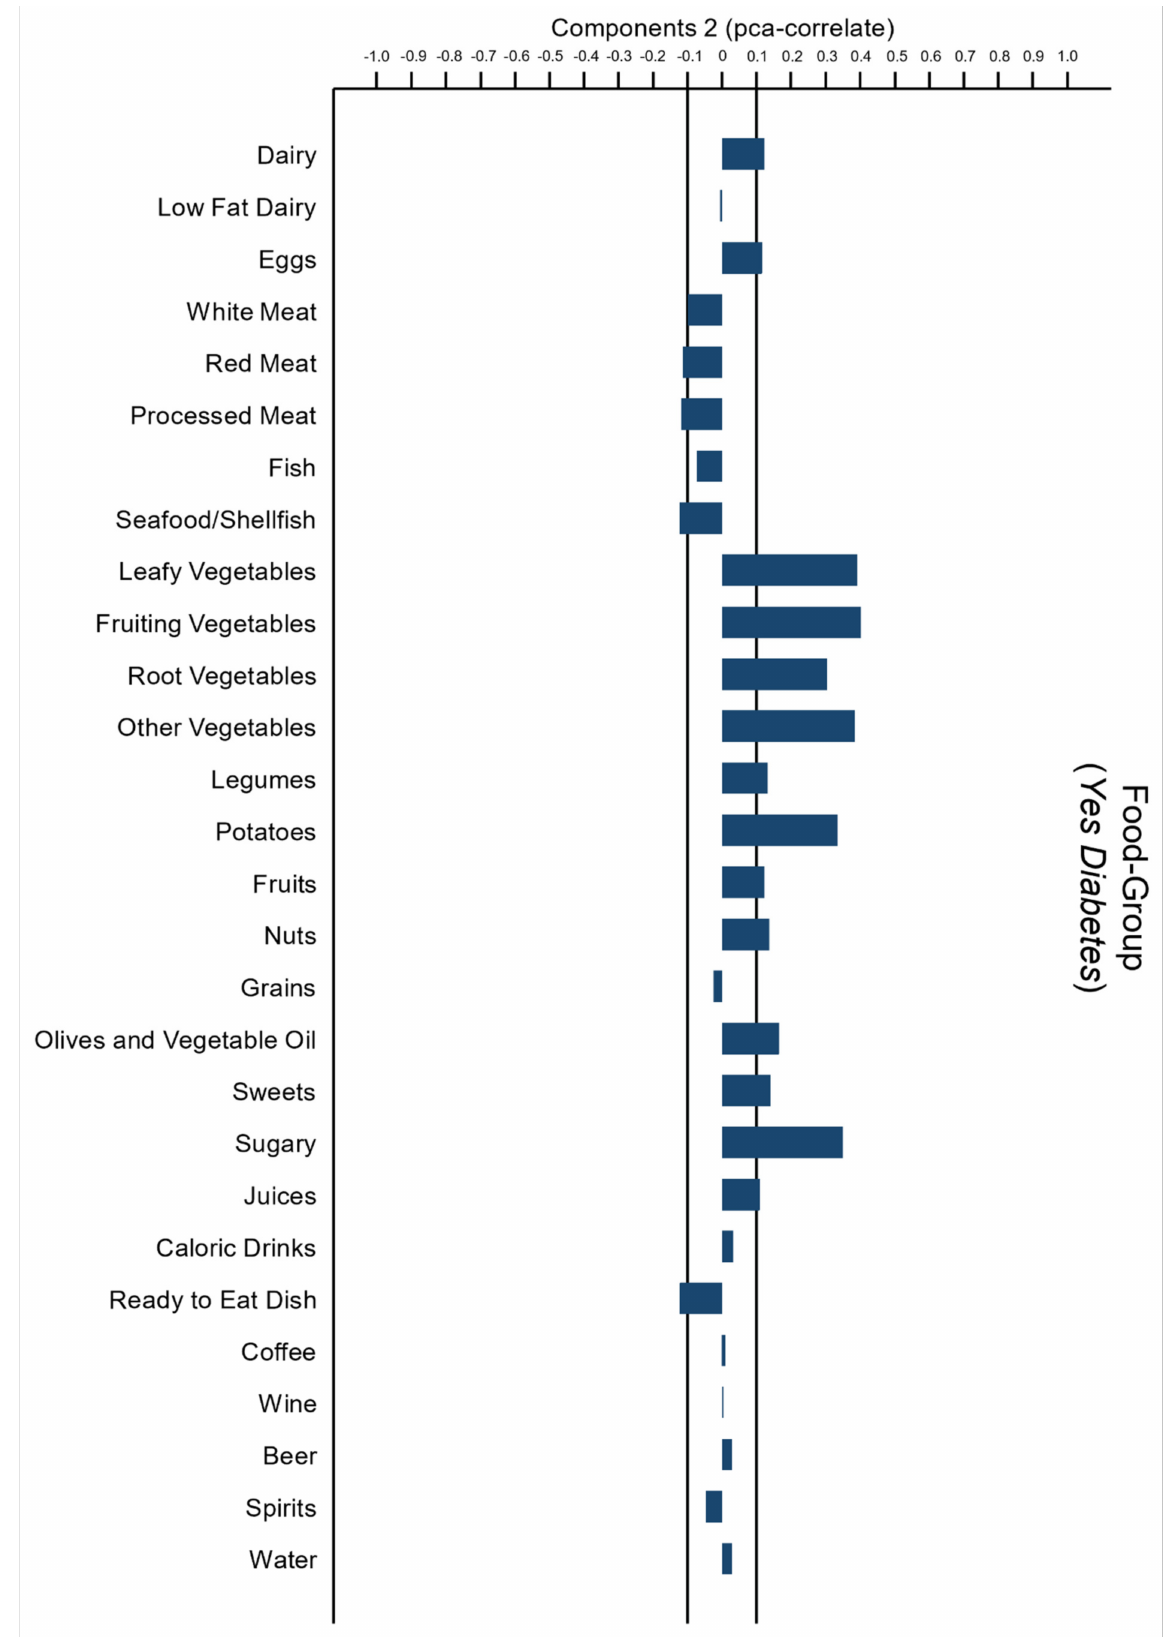
Figure 1. Principal component analysis (PCA) used to identify a dietary pattern of “Diabetic”